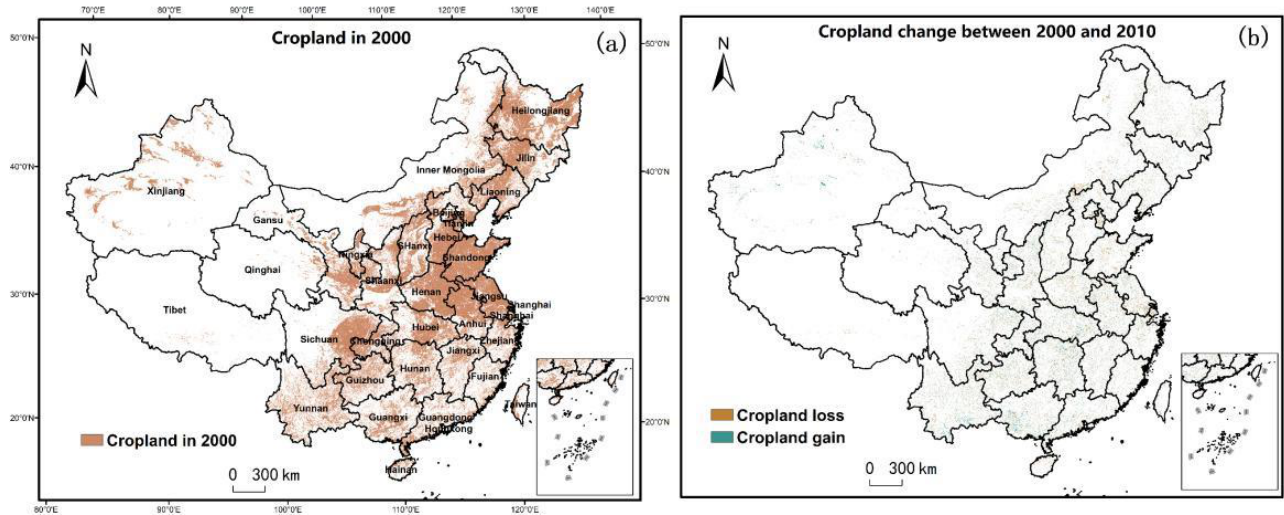
Figure 2. Spatial pattern of cropland in GlobeLand30 (( a ): 2000, ( b ): 2000 – 2010). Note that the overall accuracy of GlobeLand30 in China has reached 80%, including the cropland layer. The maps were generated using ArcGIS 10.2 ESRI (Environmental Systems Research Institute, 2013). Table 1. Data used in this paper.